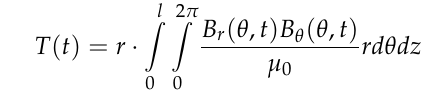
Figure 10. No-load back-EMF characteristics with the variation of the speed of the output rotor in the inner and outer windings: ( a ) Fundamental component and THD in the inner winding; ( b ) Fundamental component and THD in the outer winding.